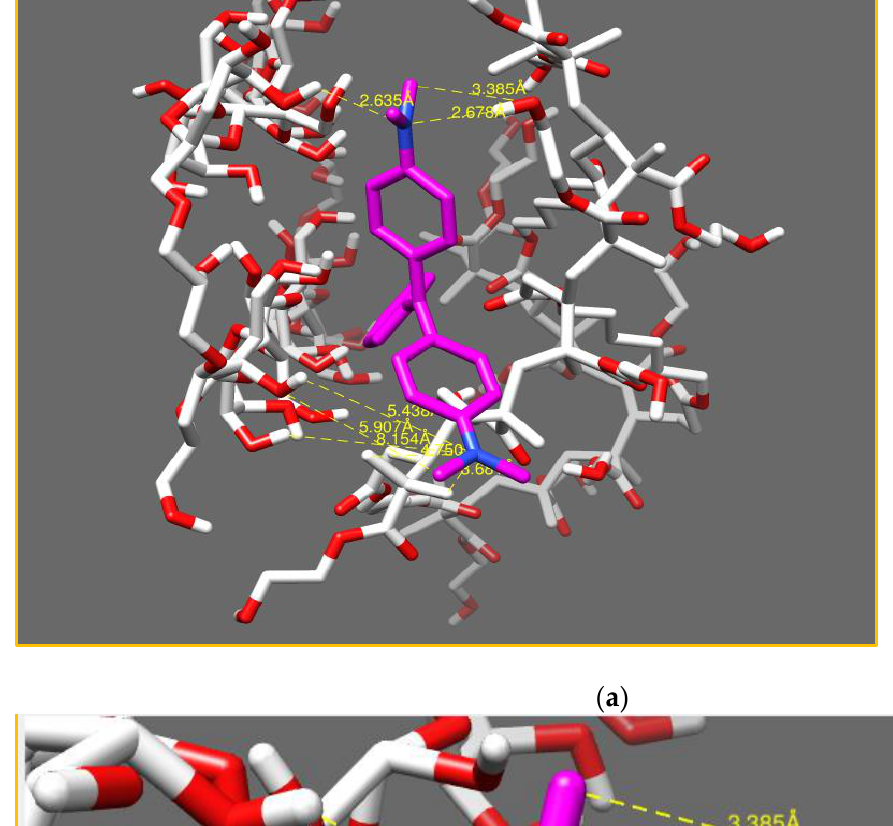
Table 4. Conformational study in the system IPN (cellulose–polyHEMA network)/malachite green dye.